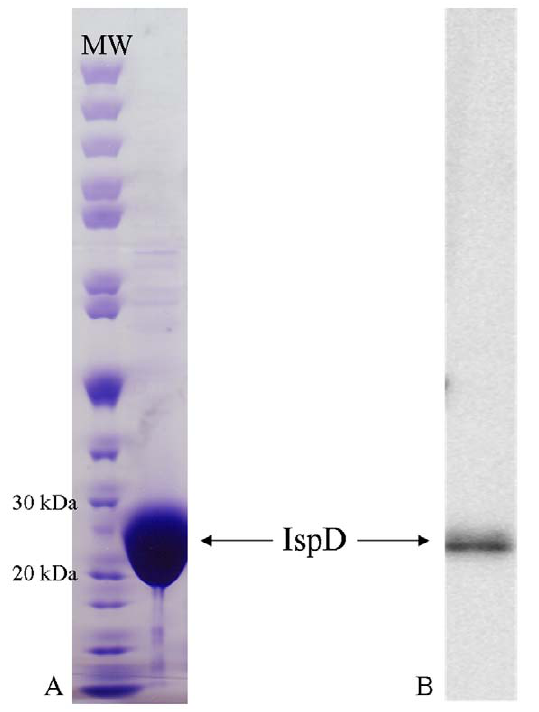
Figure 3. Substrate dependent activity of F. tularensis MEP cytidylyltransferase. Michaelis-Menten plot of reaction velocity as a function of A) MEP concentration and B) CTP concentration. The solid line represents the nonlinear least-squares best fit of the data to the Michaelis-Menten equation. Each assay was performed in duplicate. The R 2 value for each plot is indicated. Kinetic parameters derived from the plots are listed in Table 1.